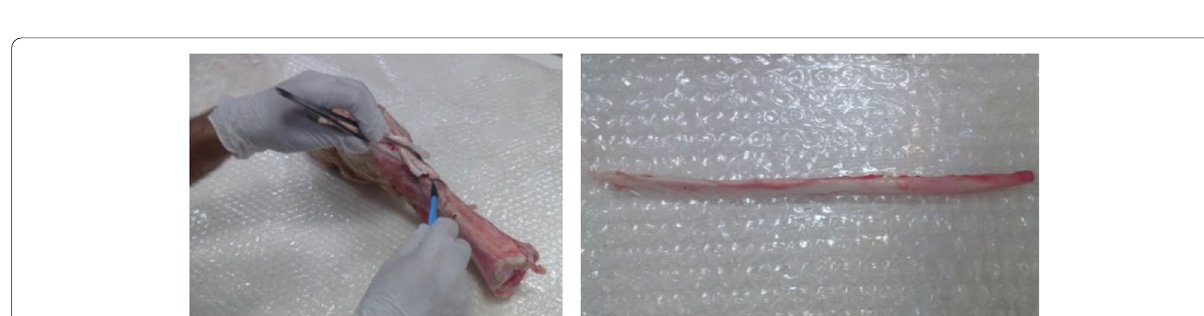
Fig. 2 Tendon harvesting procedure from a bovine hoof and a harvested tendon